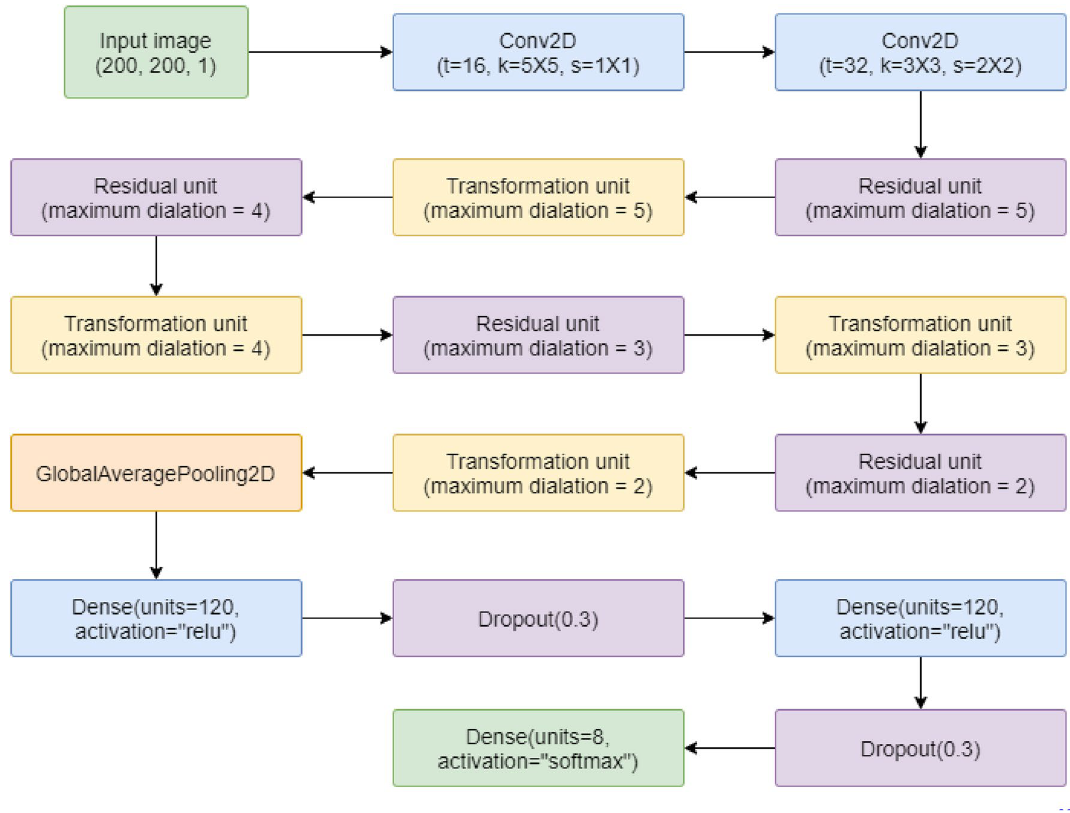
Figure 2. A schematic diagram of the proposed IRFacExNet model used for HFER. Image is developed using Draw.io 32